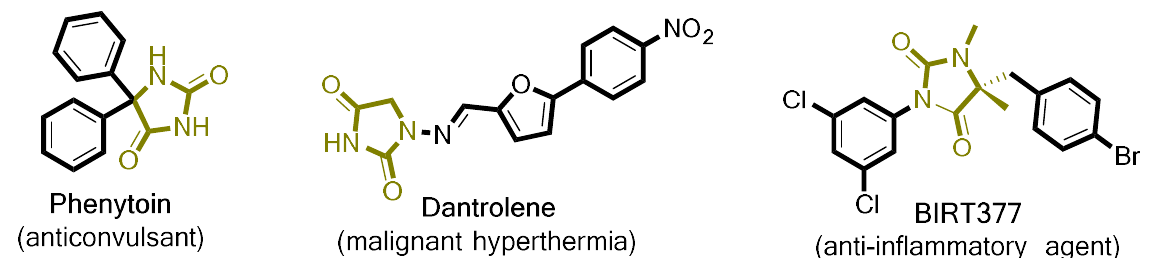
Figure 1. Chemical structures of hydantoin-containing compounds with important biological